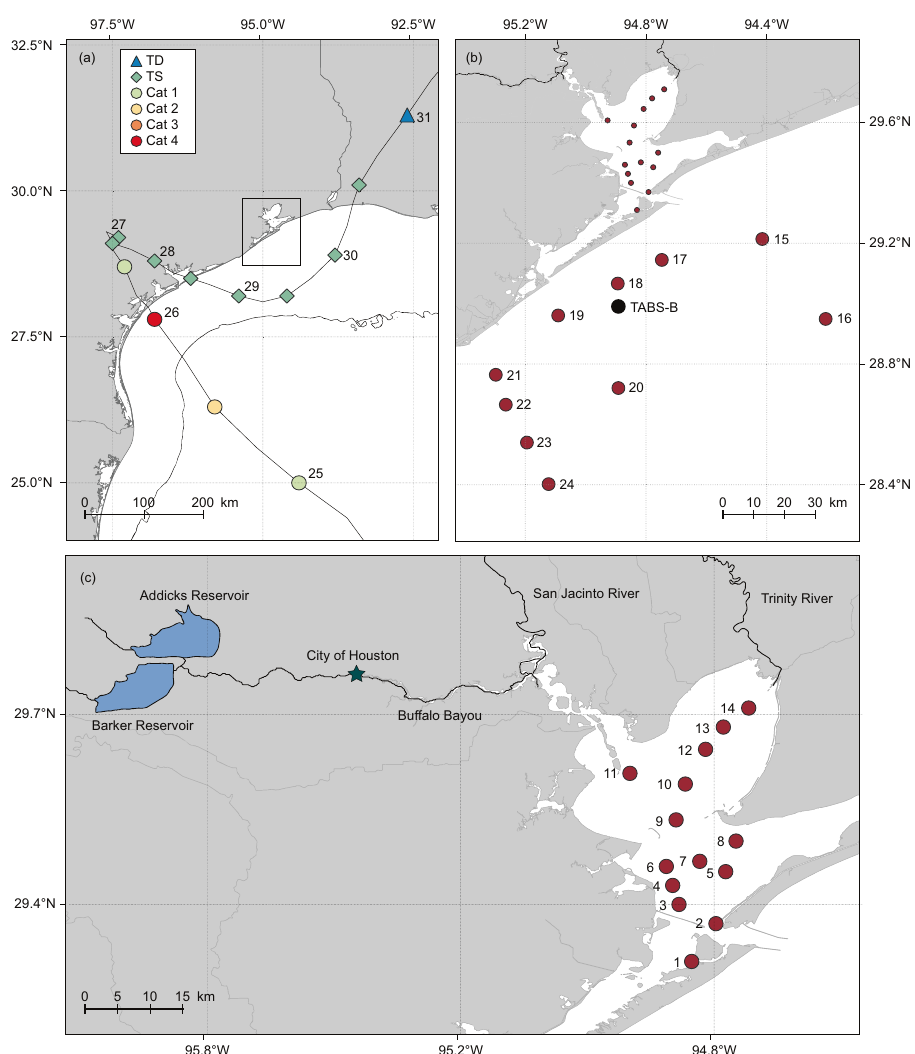
Fig. 1 Maps of the study area showing the path of Hurricane Harvey and sampling locations. a This map shows the path of Hurricane Harvey through Texas and Louisiana, with points marking 12-h intervals beginning August 25 (data from National Hurricane Center archive, https://www.nhc.noaa.gov/ data/). The shape and colors represent the storm severity at each timepoint (Tropical Depression (TD), blue triangle; Tropical Storm (TS), teal diamond; and Hurricane, circles (Cat 1, green; Cat 2, yellow; Cat 3, orange; Cat 4, red)). The 200 m isobath identifying the shelf break is outlined in gray on the map. The black box indicates zoomed area in b showing stations 15 – 24 on the Texas coast in the Gulf of Mexico in red, as well as the location of Texas Automated Buoy System, buoy B (TABS-B) in black. c Is a map of Galveston Bay showing sampling sites 1 – 14 in red and the relative location of the Addicks and Barker reservoirs colored in blue. The Trinity River, San Jacinto River, and Buffalo Bayou are marked in ( c ) with black lines and the city of Houston is marked by a